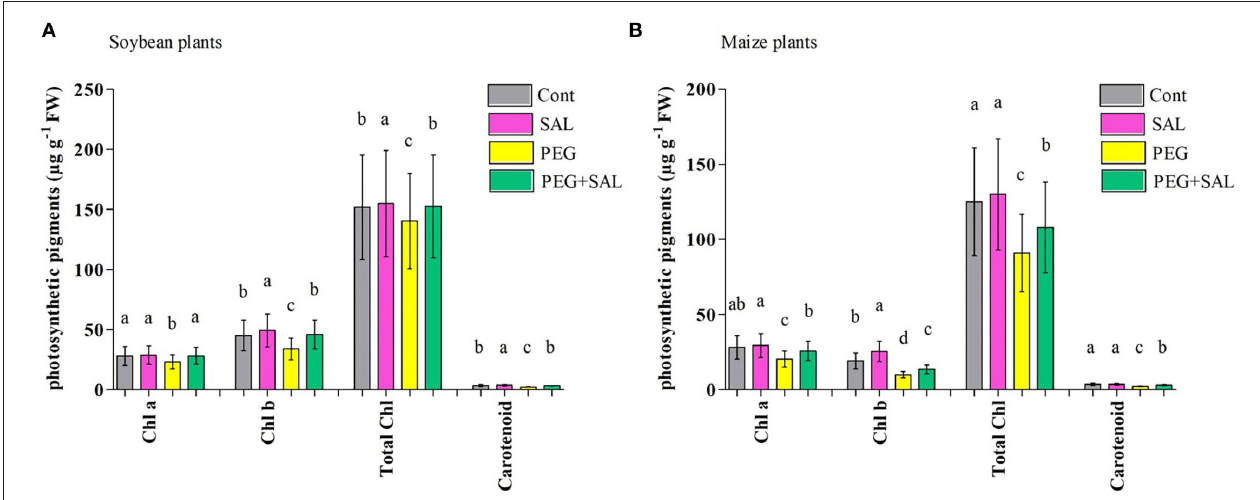
FIGURE 3 | Effect of salvianolic acid application on soybean and maize plant photosynthetic parameters “chlorophyll a, Chla; chlorophyll b, Chlb; total chlorophyll, total Chl; and carotenoid contents” (A,B) . Treatments: Cont (control), SAL (0.1 µ M salvianolic acid), SAL (1 µ M salvianolic acid), PEG (25% polyethylene glycol), SAL (0.1 µ M salvianolic acid) + PEG (25% polyethylene glycol), and SAL (1 µ M salvianolic acid) + PEG (25% polyethylene glycol). Values show the mean ± SE ( n = 6) and significant differences at p < 0.05 (Tukey’s test). Bars with different lowercase letters are significantly different from each